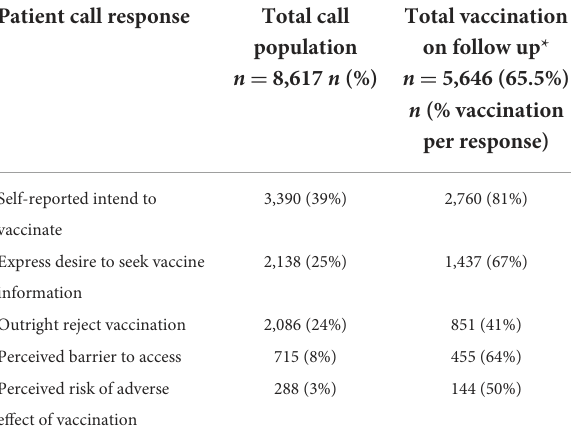
TABLE 2 Patient call response and vaccination uptake on follow up for phase I patient